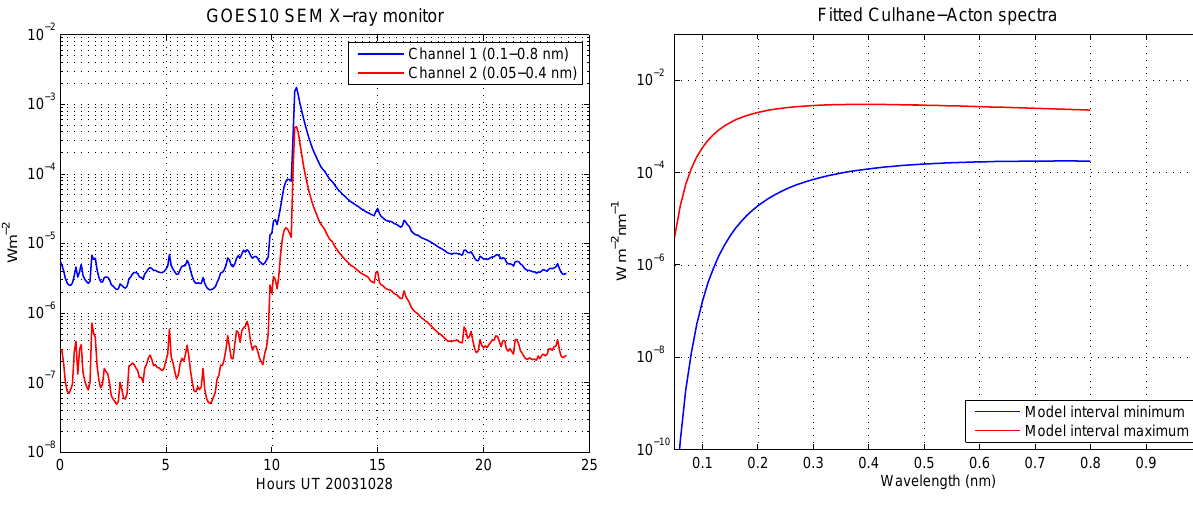
Fig. 2. Left plot: The GOES X-ray channels for the 28 October 2003 event. It should be noted that the wider channel saturated during the maximum. Right plot: Fitted spectra for the maximum (around 11:10UT) and minimum (X-rays switched on at 10:50UT) fluxes during the model run. Similar spectra fitted to 5-min average GOES data were used throughout the flare runs. The solar zenith angle was around 83 ◦ throughout the event, since it occurred close to local noon. See Sect. 3 for details.